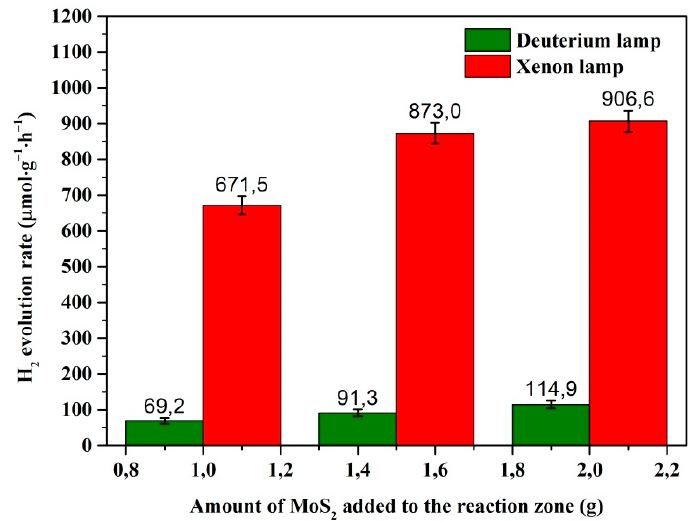
Figure 6. Rate of H 2 production by MoS 2 –ZnO nanoheterostructures. Measurement conditions: 0.06 g sample, 100 mL aqueous solution of 0.1 M Na 2 S with 0.05 M Na 2 SO 3 , and light sources of 150 W Xe and 30 deuterium lamp.